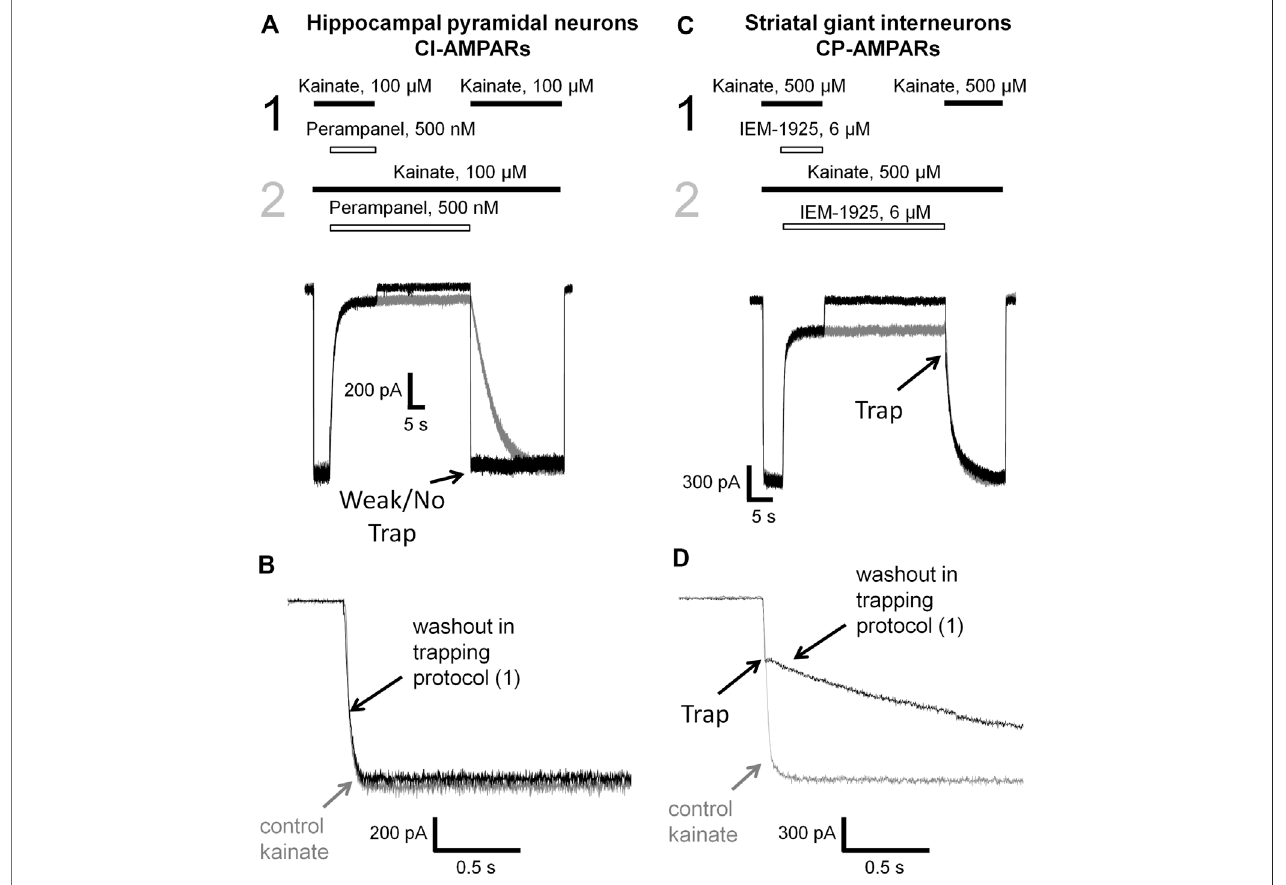
FIGURE 6 | Perampanel is not trapped in closed AMPAR channels in contrast to IEM-1925. (A) Representative example of the absence of trapping for 500 nM perampanel in the double-pulse protocol (black traces) and its recovery kinetics in the protocol without pause in extracellular solution (gray traces) on hippocampal pyramidal neuron. (B) Superimposition ofrising fronts in control kainate application and testing kainate application in the double-pulse protocol for 500 nM perampanel. (C) Representative example of trapping for 6 µM IEM-1925 in the double-pulse protocol (black traces) and its recovery kinetics in the protocol without pause in extracellular solution (gray traces) on striatal giant interneuron. (D) Superimposition of rising fronts in control kainate application and testing kainate application in the double-pulse protocol for 6 µM IEM-1925.